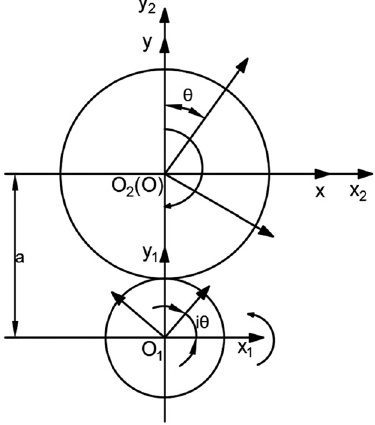
Figure 1: Coordinate system for solving the involute pro fi le of the gear shaper cutter [ 33 ]